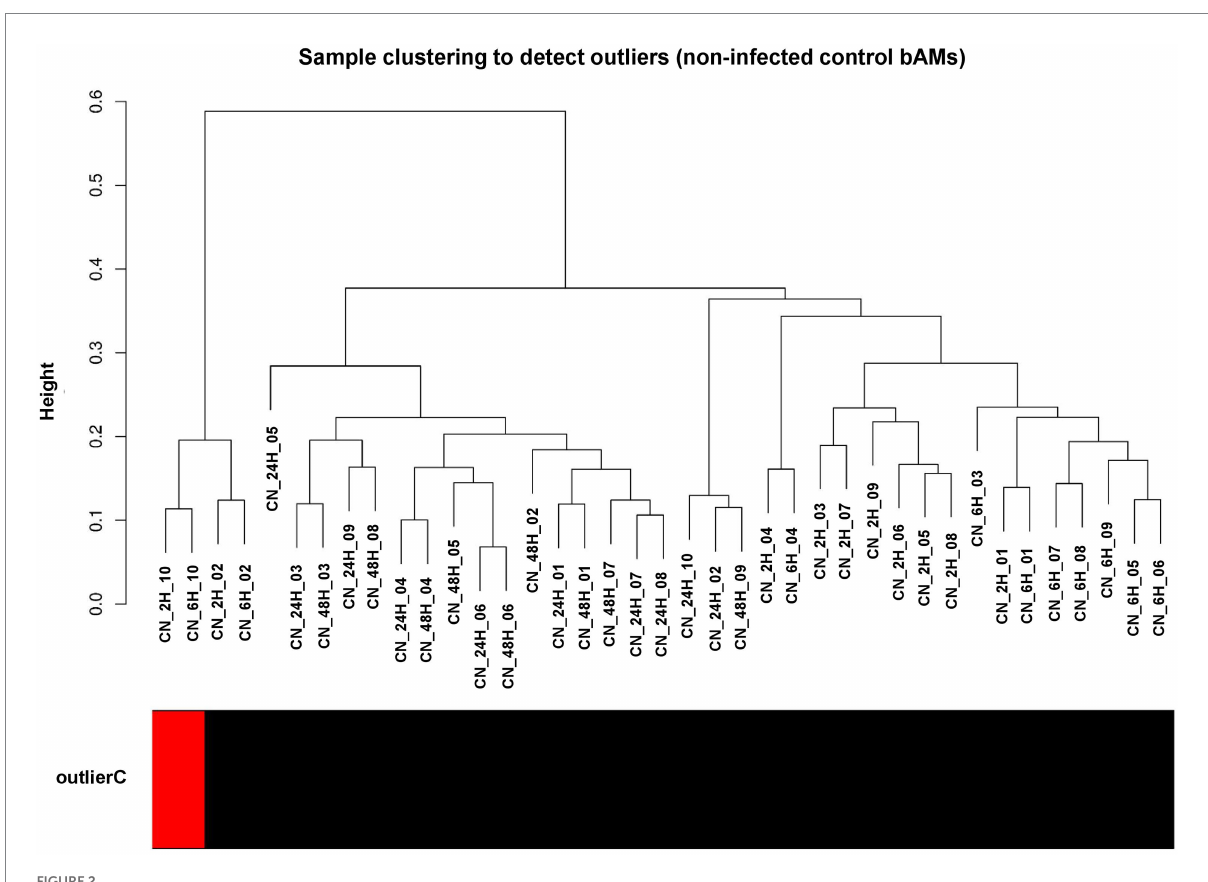
FIGURE 2 Sample clustering to detect outliers in the non-infected controls bAMs as reference set for module detection. Based on the adjacency matrices of samples, two samples including GSM1528042 and GSM1528044 had a standardized connectivity score < −2.5 and were excluded as